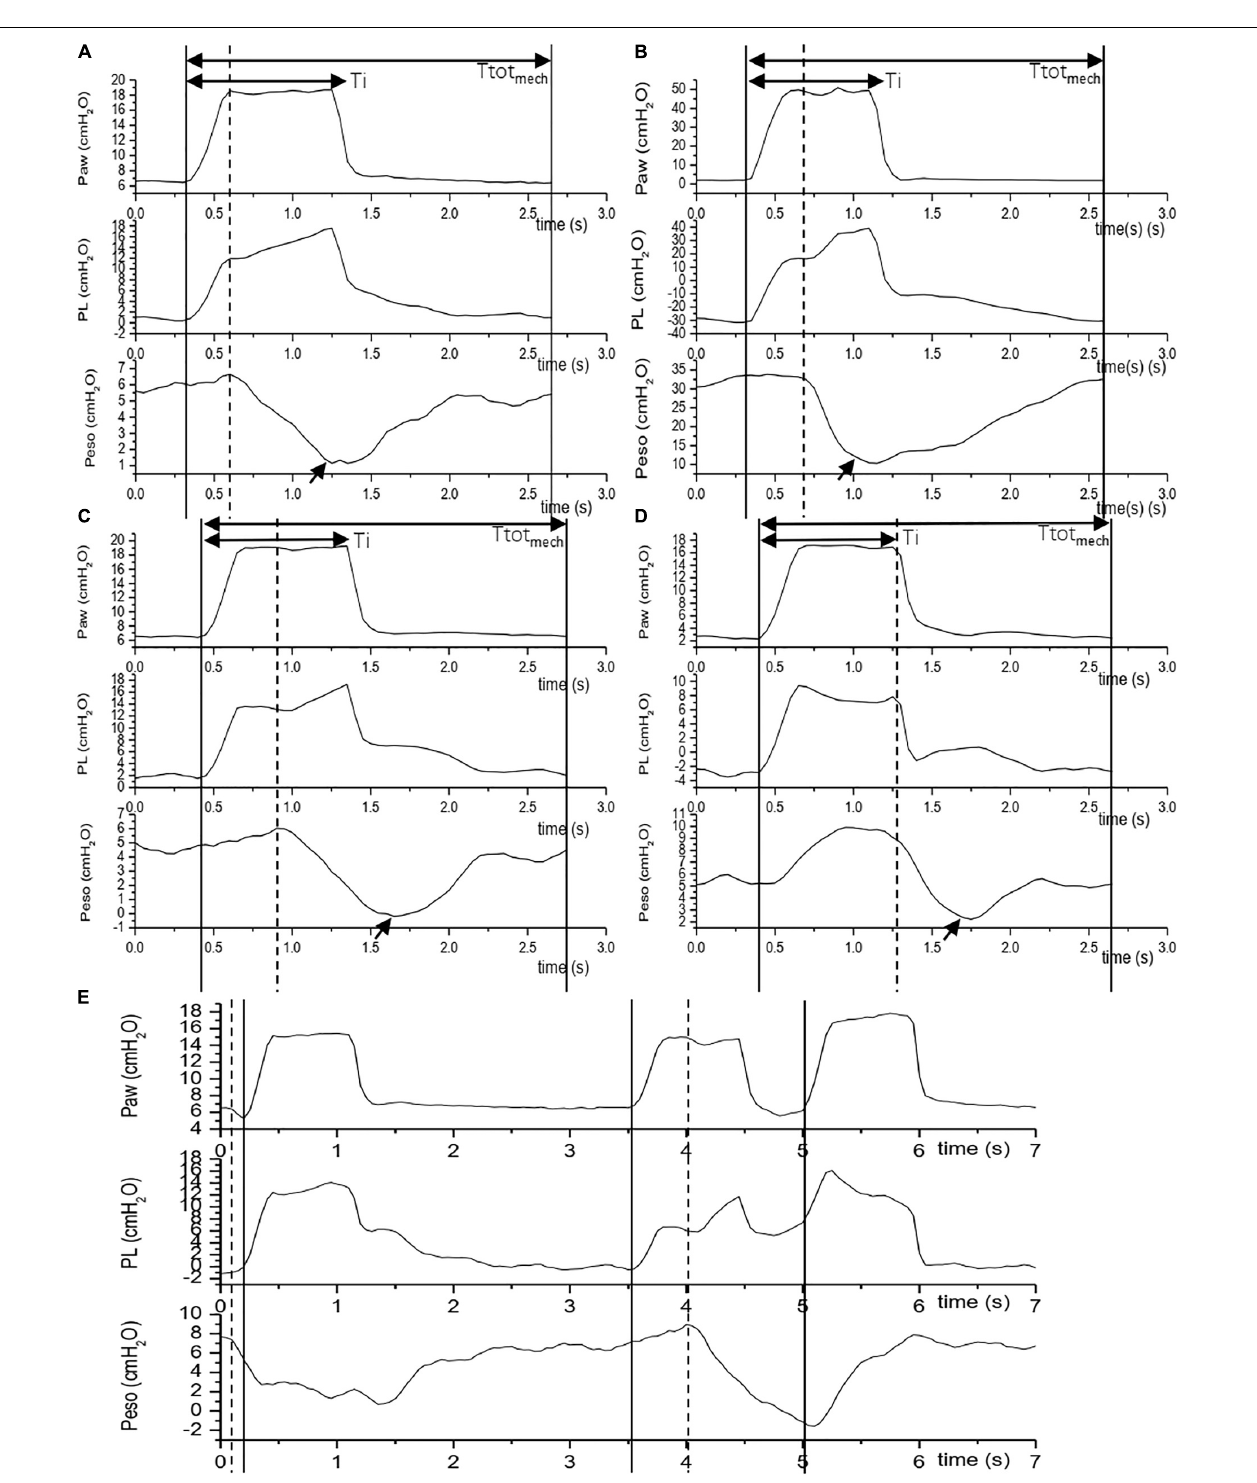
FIGURE 2 | Reverse trigger phenotypes. The figure shows 5 Reverse trigger phenotypes during assist/control ventilation. The vertical solid line indicates an initiation of a mandatory breath, the vertical dashed line indicates an initiation of a patient effort which is express as the negative fluctuation of esophageal pressure, the arrow indicates maximal Inspiratory effort or maximal delta esophageal pressure (Peso). If an initiation of a patient effort precede a mandatory breath, we define it is an assist breath [e.g., the first breath in (E) ]. If a patient effort emerge after an initiation of a mandatory breath, we define it is a breath with Reverse trigger [e.g., (A–D) ]. Depending on the time phase of initiation of a patient effort and maximal delta Peso, a Reverse trigger was defined as different phenotypes according to